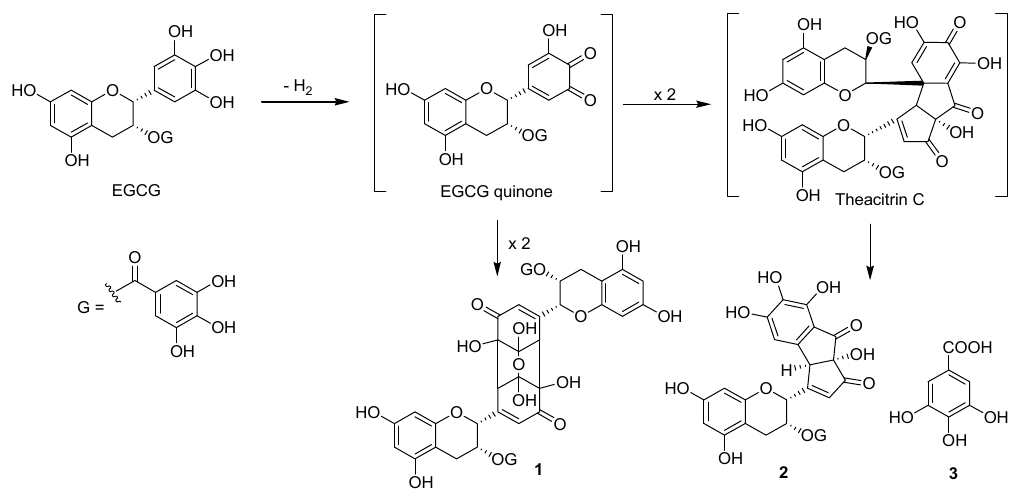
Figure 3. Proposed pathway for the oxidation of EGCG in aqueous solution by non-thermal plasma.